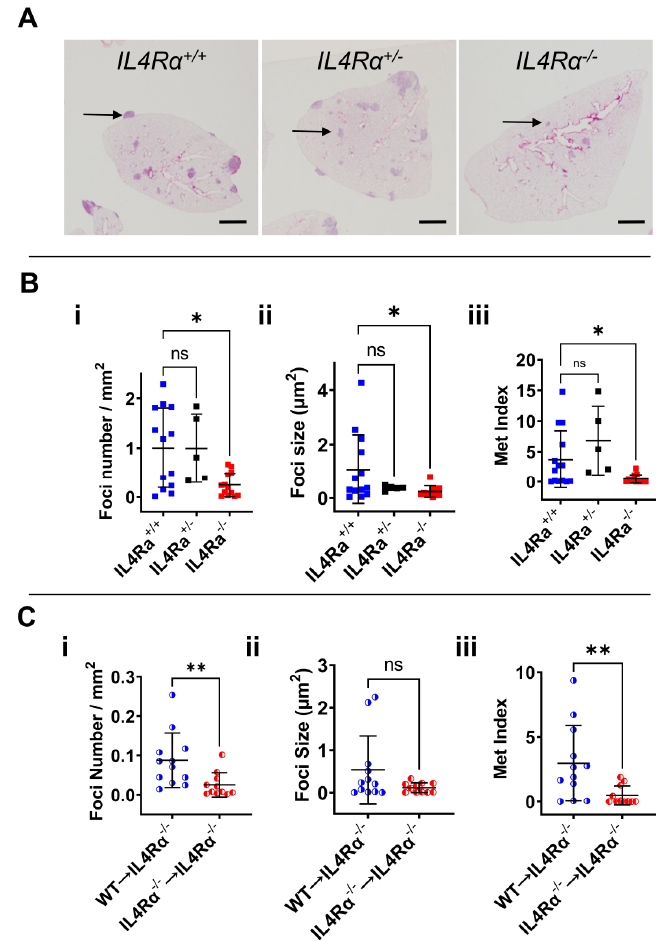
Figure 2. IL4 signaling is important for pulmonary metastatic colonization. ( A ) Hematoxylin-and- eosin-stained sections of the lungs from WT, IL4Rα +/− and IL4Rα −/− mice intravenously injected with syngeneic E0771-LG cells 11 days post-injection. Scale bar = 1 mm. ( B ): ( i ) Stereological quantifica- tion of foci number in WT, IL4Rα +/− and IL4Rα −/− mice 11 days after intravenous injection of E0771- LG cells by counting the number of all foci every 100 µm interval in a total of six sections. Graphs correspond to 5 to 13 mice per group with bars representing average +/− SD. Kruskal–Wallis test, * p -value < 0.05. ( ii ) Stereological quantification of foci size in WT, IL4Rα +/− and IL4Rα −/− mice 11 days after intravenous injection of E0771-LG cells, calculated after measuring the area of all foci every 100 µm interval in a total of six sections. Graphs correspond to 5 to 13 mice per group with bars representing average +/− SD. Kruskal–Wallis test, * p -value < 0.05. ( iii ) Stereological quantification of the metastatic index, the ratio of total foci area by lung area, in WT, IL4Rα +/− and IL4Rα −/− mice 11 days after intravenous injection of E0771-LG cells. Graphs correspond to 5 to 13 mice per group with bars representing average +/− SD. Kruskal–Wallis test, * p -value < 0.05. ( C ): ( i ) Stereological quanti- fication of foci number in IL4Rα − / − mice adoptively transferred with WT (WT to IL4Rα −/− ) or IL4Rα −/− ( IL4Rα −/− to IL4Rα −/− ) monocytes immediately after E0771-LG cell injection. Graphs correspond to 11 to 12 mice per group with bars representing average +/− SD. Mann–Whitney test, n > 11/group, ** p - value < 0.005. ( ii ) Stereological quantification of foci size in IL4Rα − / − mice adoptively transferred with WT (WT to IL4Rα −/− ) or IL4Rα −/− ( IL4Rα −/− to IL4Rα −/− ) monocytes immediately after E0771-LG cell injection. Graphs correspond to 11 to 12 mice per group with bars representing average +/− SD. Mann–Whitney test, n > 11/group, p -value > 0.05. ( iii ) Stereological quantification of metastatic index in IL4Rα − / − mice adoptively transferred with WT (WT to IL4Rα −/− ) or IL4Rα −/− ( IL4Rα −/− to IL4Rα −/− ) monocytes immediately after E0771-LG cell injection. Graphs correspond to 11 to 12 mice per group